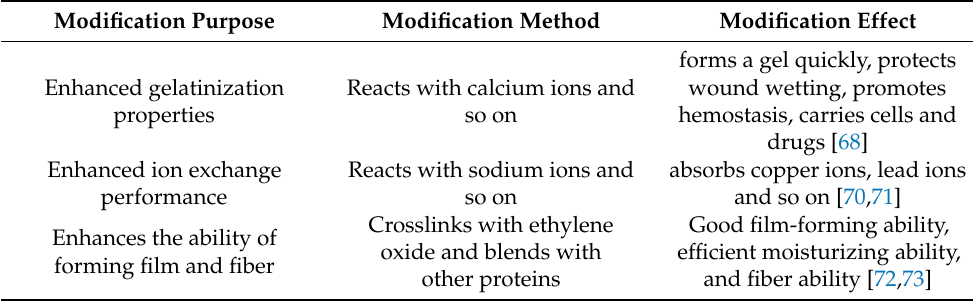
Table 2. Purpose, methods, and effects of directional modification of